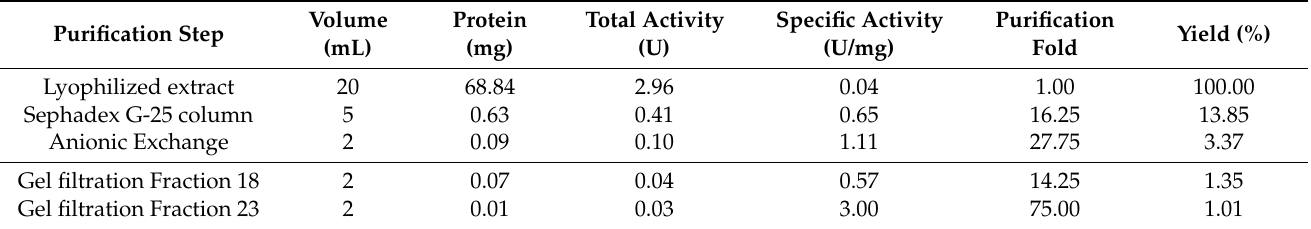
Table 1. Purification strategy for extracellular EAH produced by Aspergillus niger